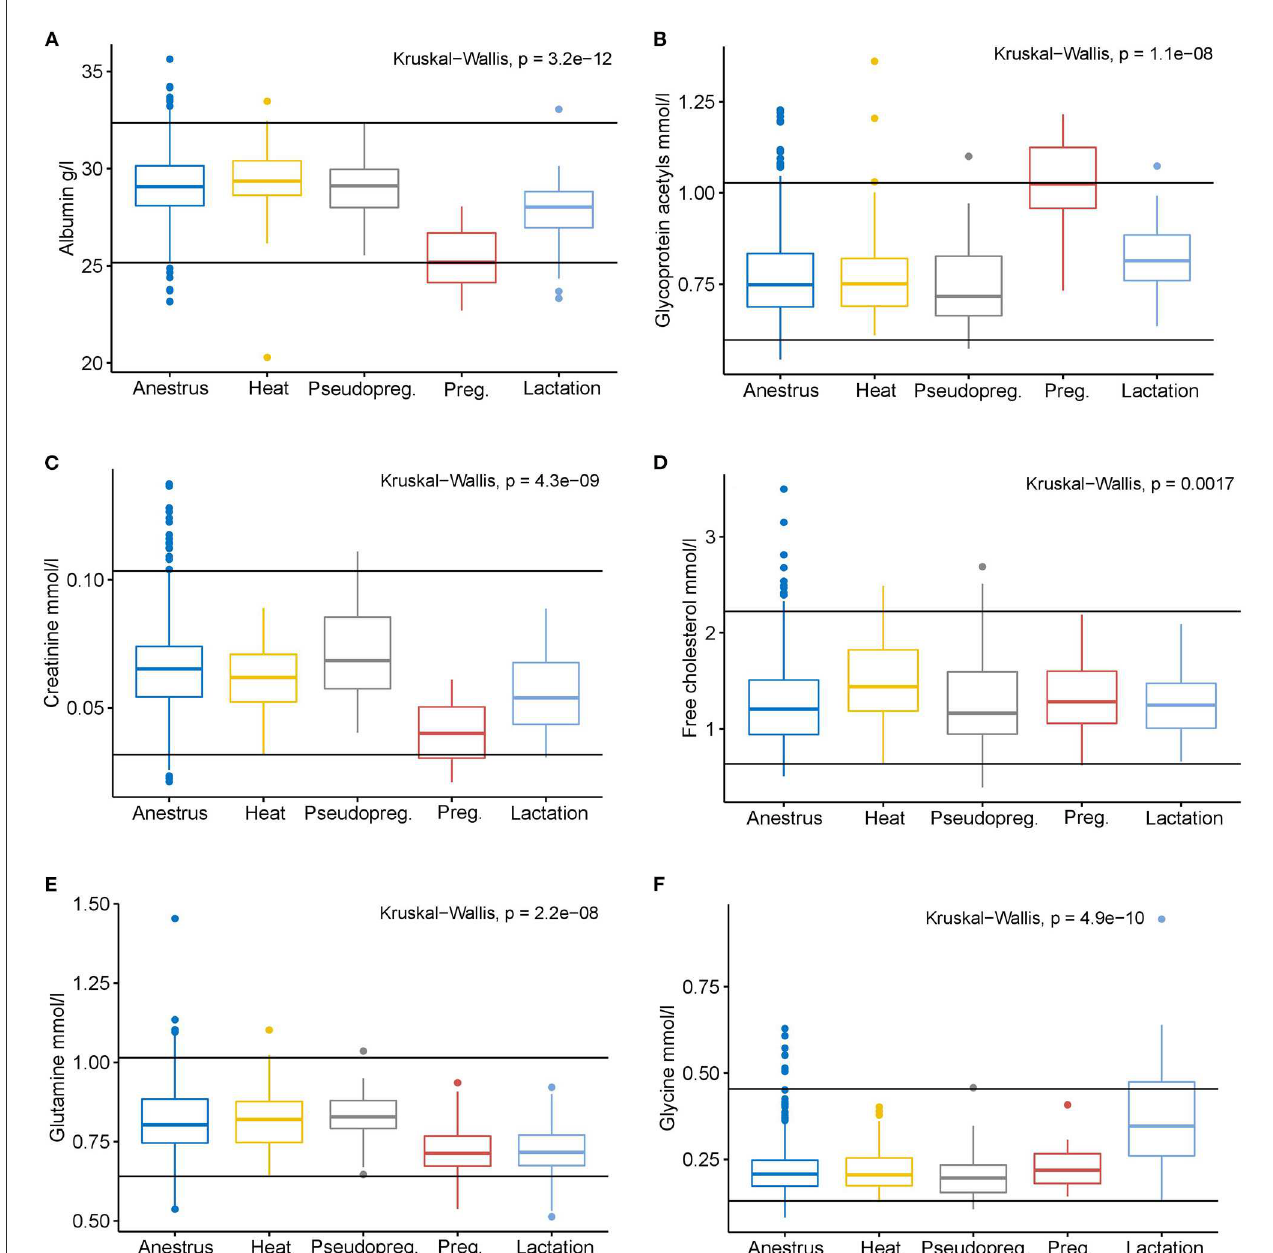
FIGURE4 Box plots of selected measurands with significantly different concentrations from anestrus in one or more of the other reproductive cycle phases according to the Kruskal-Wallis test. The black horizontal lines indicate the serum all dogs’ reference intervals of the NMR method (Ottka et al. 2021). Anestrus n = 663, heat n = 78, pseudopregnancy (Pseudopreg.) n = 43, pregnancy (Preg.) n = 15, lactation n = 38. (A) Albumin, (B) Glycoprotein acetyls, (C) Creatinine, (D) Free cholesterol, (E) Glutamine, (F)